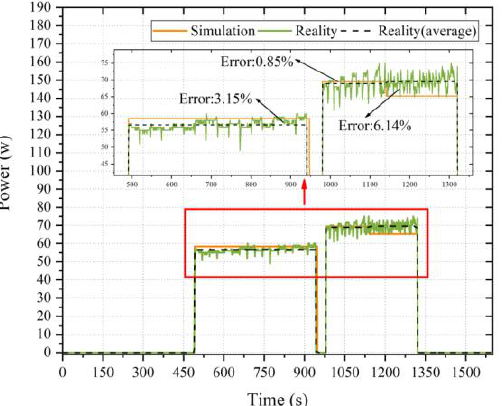
Figure 26. Comparison curve between simulated power and actual machining power.